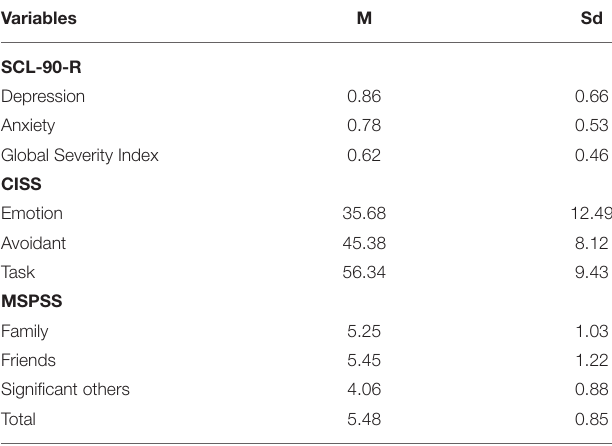
TABLE 1 | Participants’ questionnaire means scale scores. TABLE 2 | Correlation between depression and anxiety, with coping, and social support